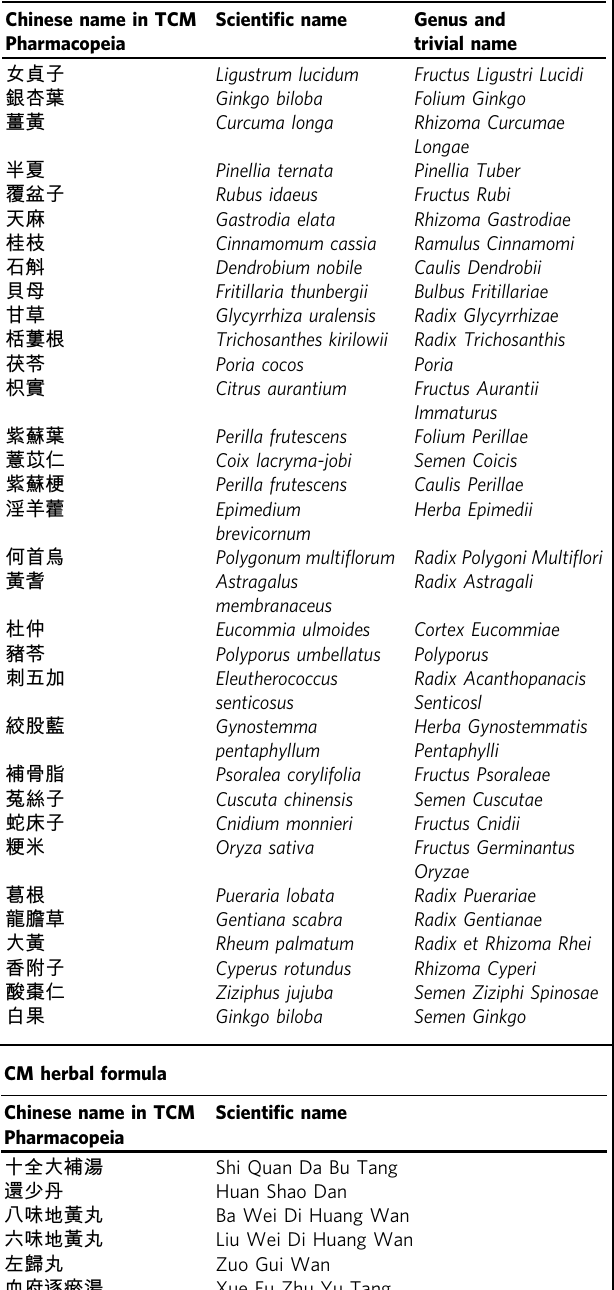
Table 1 Lists of TCM single herbs and herbal formulas in the TCM pharmacopeia that are suggested to treat age-related diseases and/or extend the